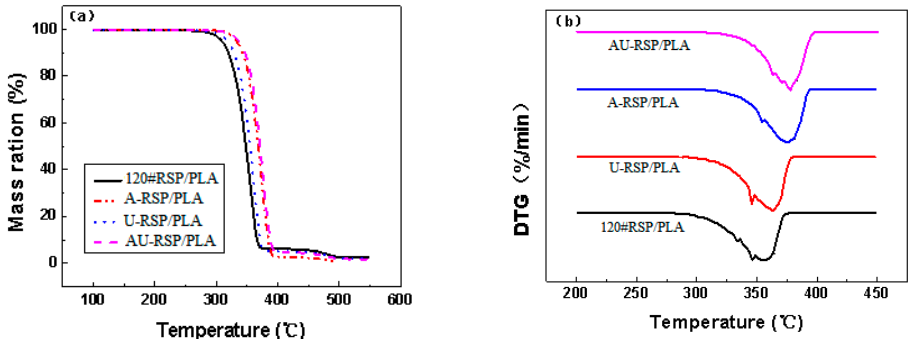
Figure 7. ( a ) TGA curves and ( b ) DTG curves for the samples at 20 K/min in a nitrogen atmosphere. Table 2. Thermal decomposition parameters for 3D-printed unmodified and modified RSP/PLA composites in a nitrogen atmosphere.